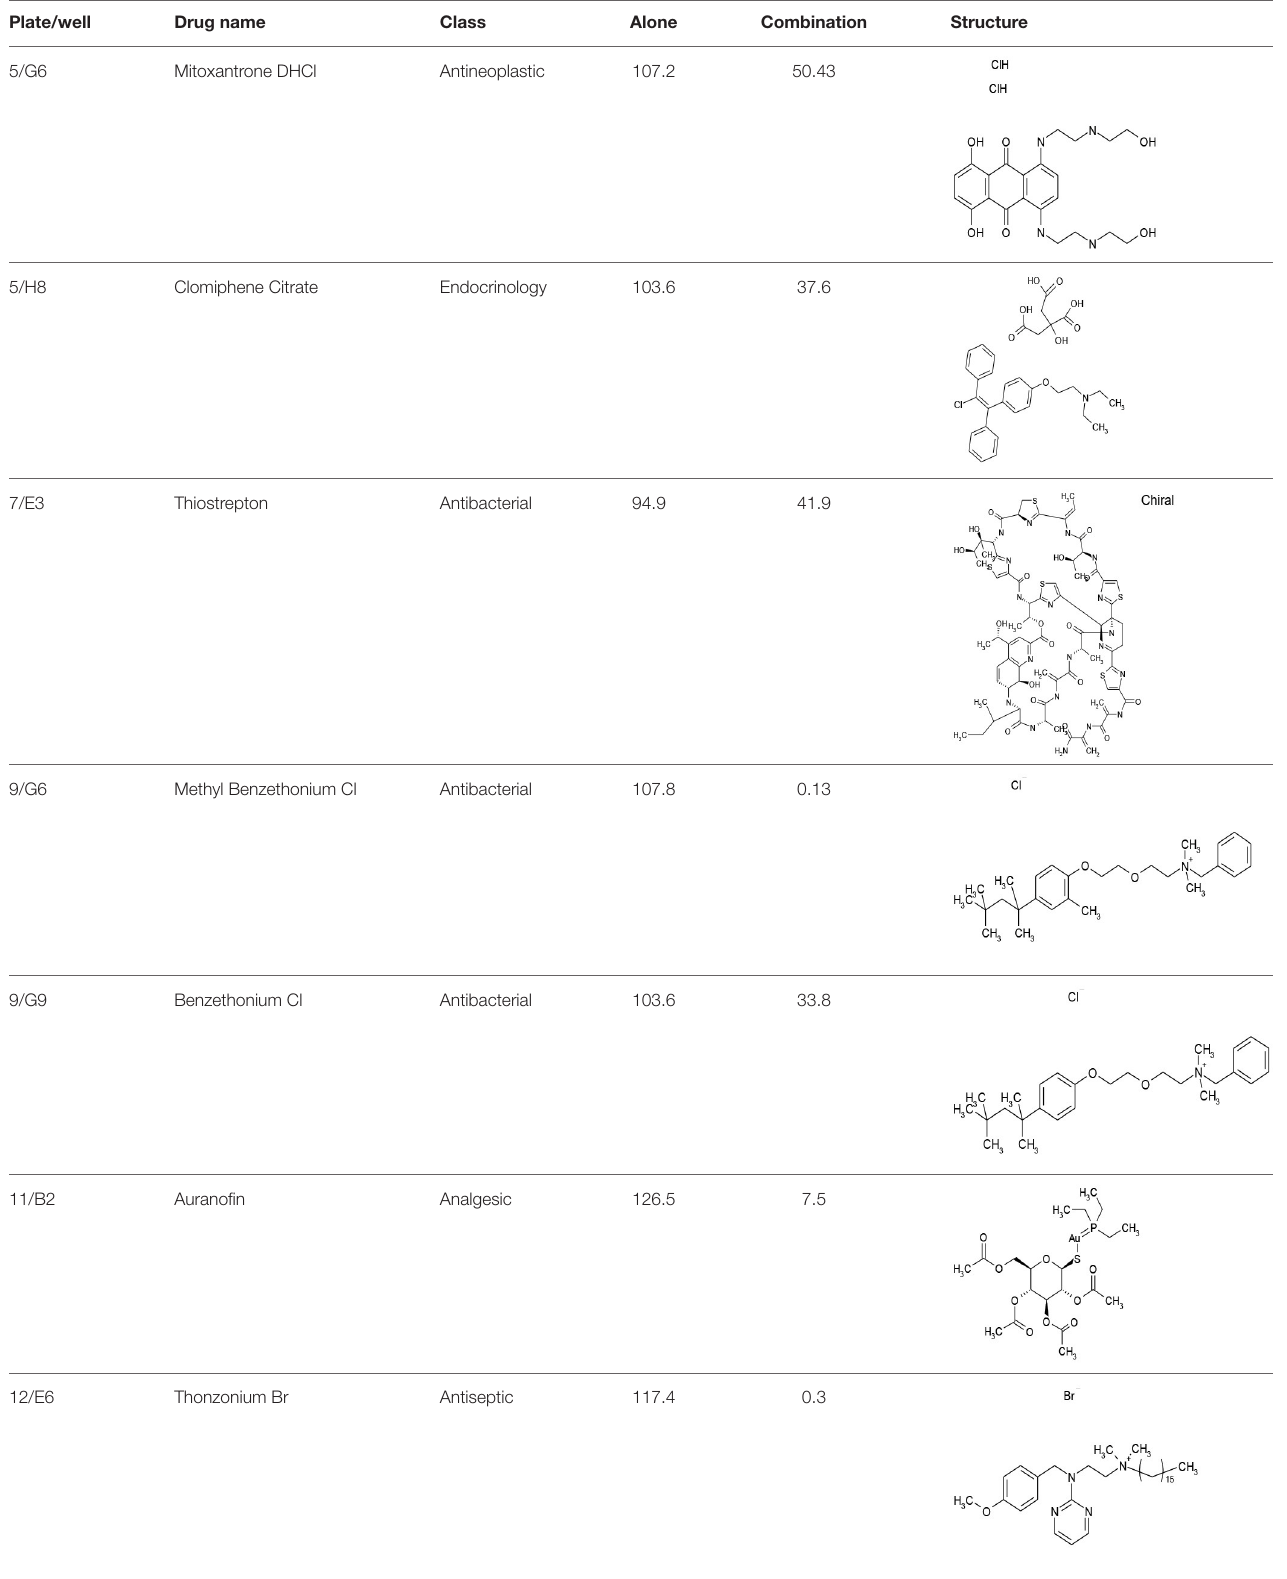
TABLE 2 | Percent survival of planktonic P. aeruginosa after treatment with drug alone and in combination with 1.56 µ g/mL Colistin.